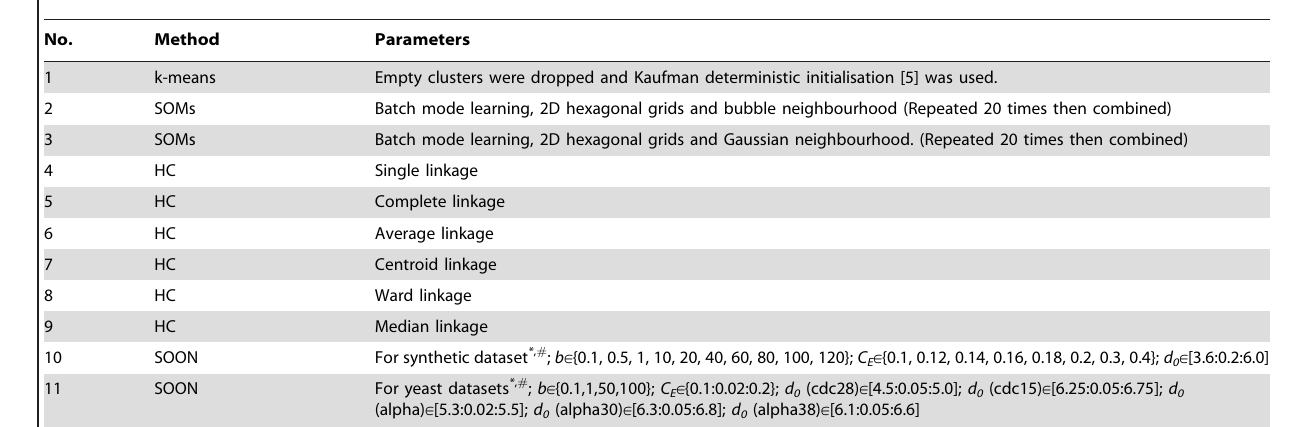
Table 1. Clustering experiments.